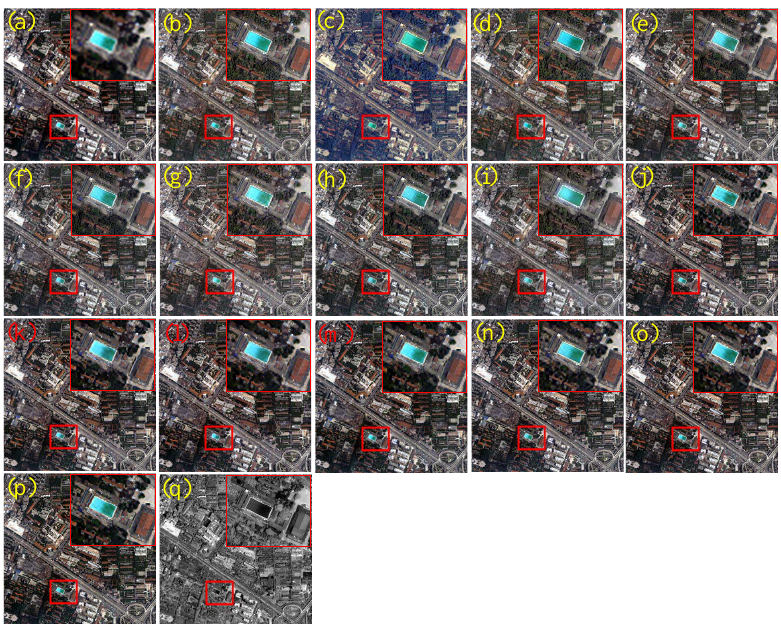
Figure 6. Visualization of image sharpening results in full resolution. The input LRMS and PAN images from the IKONOS dataset with sizes of 256 × 256 and 1024 × 1024, respectively. The enlarged red box view is located in the upper left corner. ( a ) EXP; ( b ) PCA; ( c ) IHS; ( d ) GS; ( e ) HPF; ( f ) SFIM; ( g ) Indusion; ( h ) FE-HPM; ( i ) PWMBF; ( j ) PNN; ( k ) DRPNN; ( l ) PercepPan; ( m ) PGMAN; ( n ) BAM;